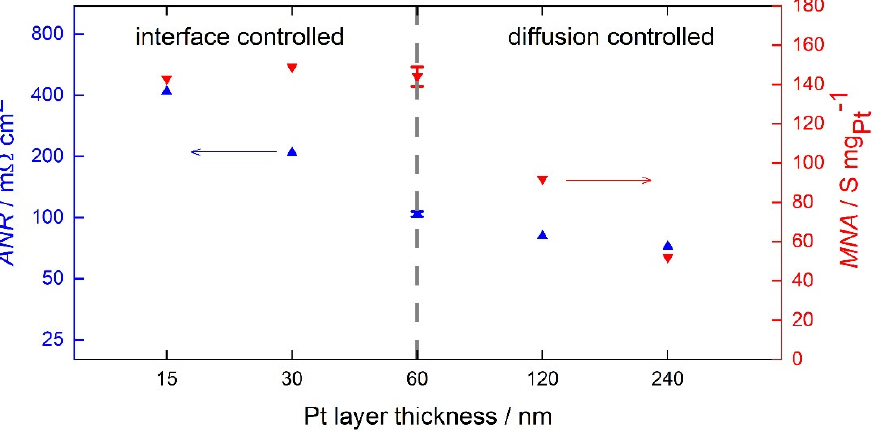
Figure 5. Double-logarithmic plot of the Pt layer thickness and the area-normalized resistance (ANR) in blue under anodic fuel cell conditions (513 K, 60 sccm H 2 and 0.3 atm H 2 O). The resulting mass-normalized activity (MNA) is plotted in red with a linear scale.